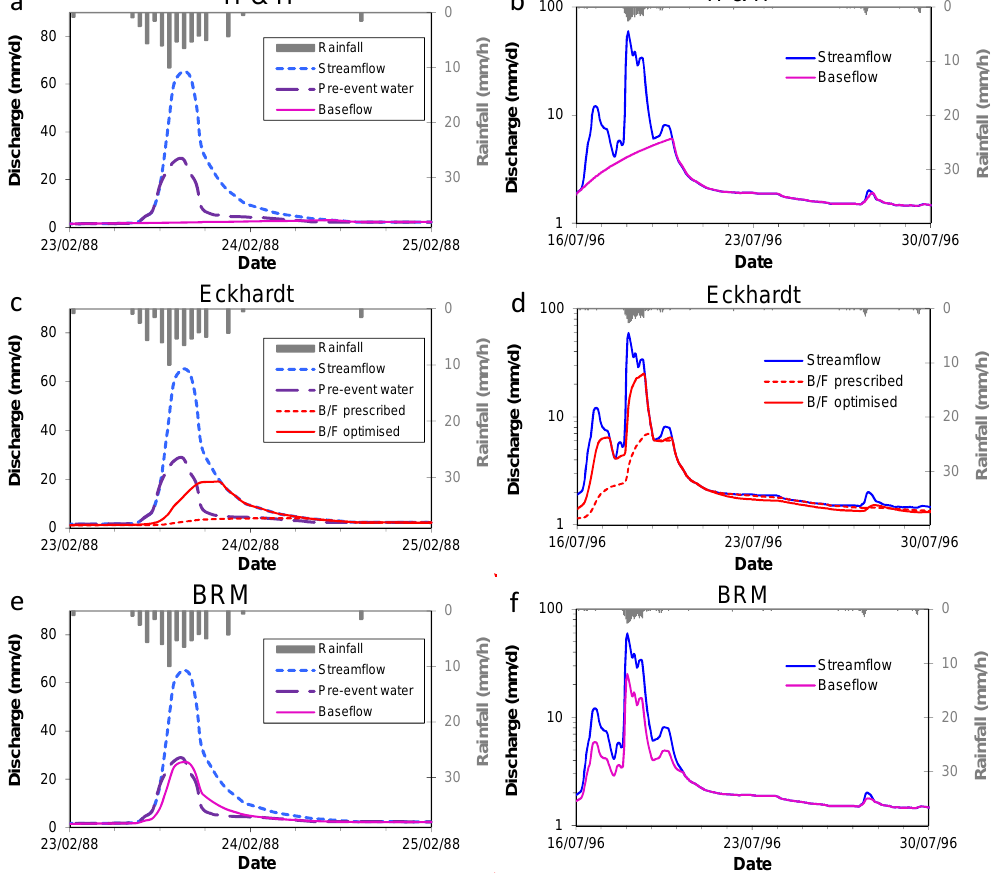
Figure 4. (a, c, e) Application of the three baseflow separation methods to fit the pre-event component determined by deuterium mea- surements at Glendhu GH1 Catchment for an event on 23 February 1988. The parameters determined by fitting are given in Table 2; (b, d, f) Baseflows resulting from the best-fit parameters for a 2-week period in 1996; note the logarithmic